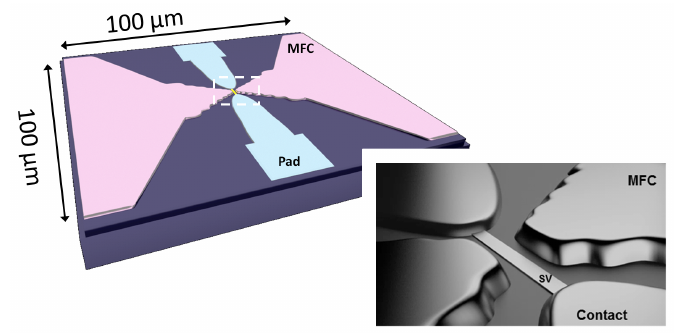
Figure 1. Illustrations of the final device layout including the spin-valve (SV) nanosensor, the electrical contacts and the magnetic flux concentrators (MFCs), all within 100 µ m by 100 µ m